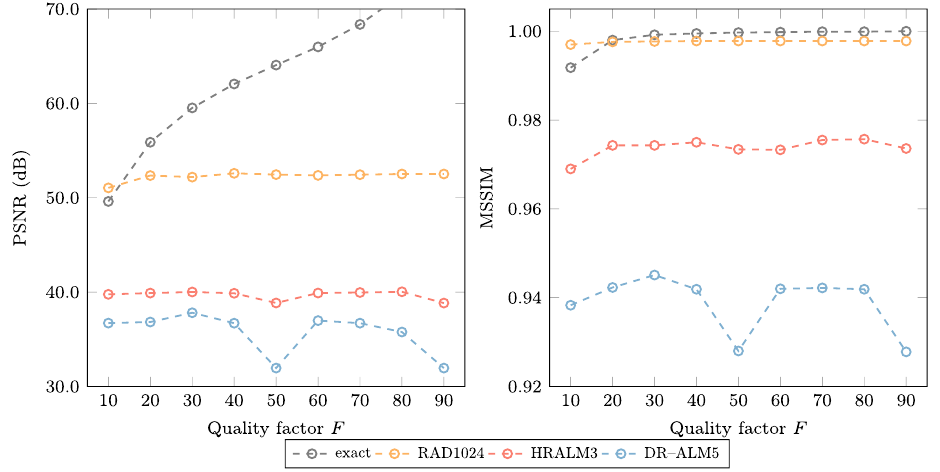
Figure 11. PSNR and MSSIM versus quality factor in lossy compression of the snails